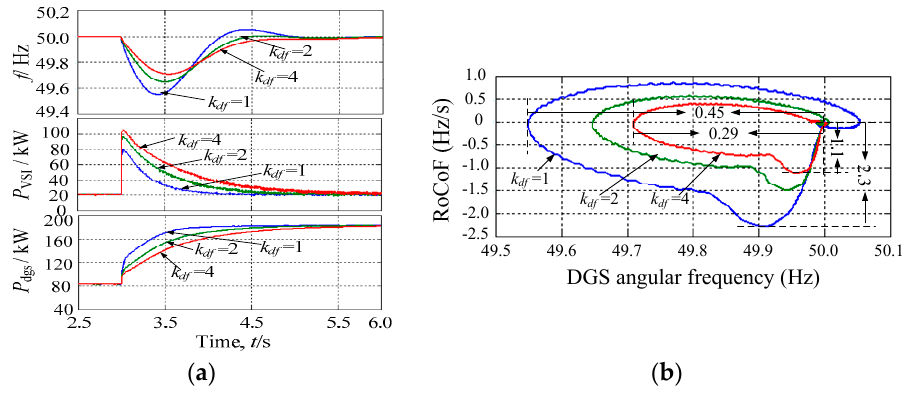
Figure 15. ( a ) Effects of the different differential feedforward gains ( D = 0 and J = 0) on an active power transient; ( b ) Angular frequency-acceleration curves of DGS with differential feedforward control loop.